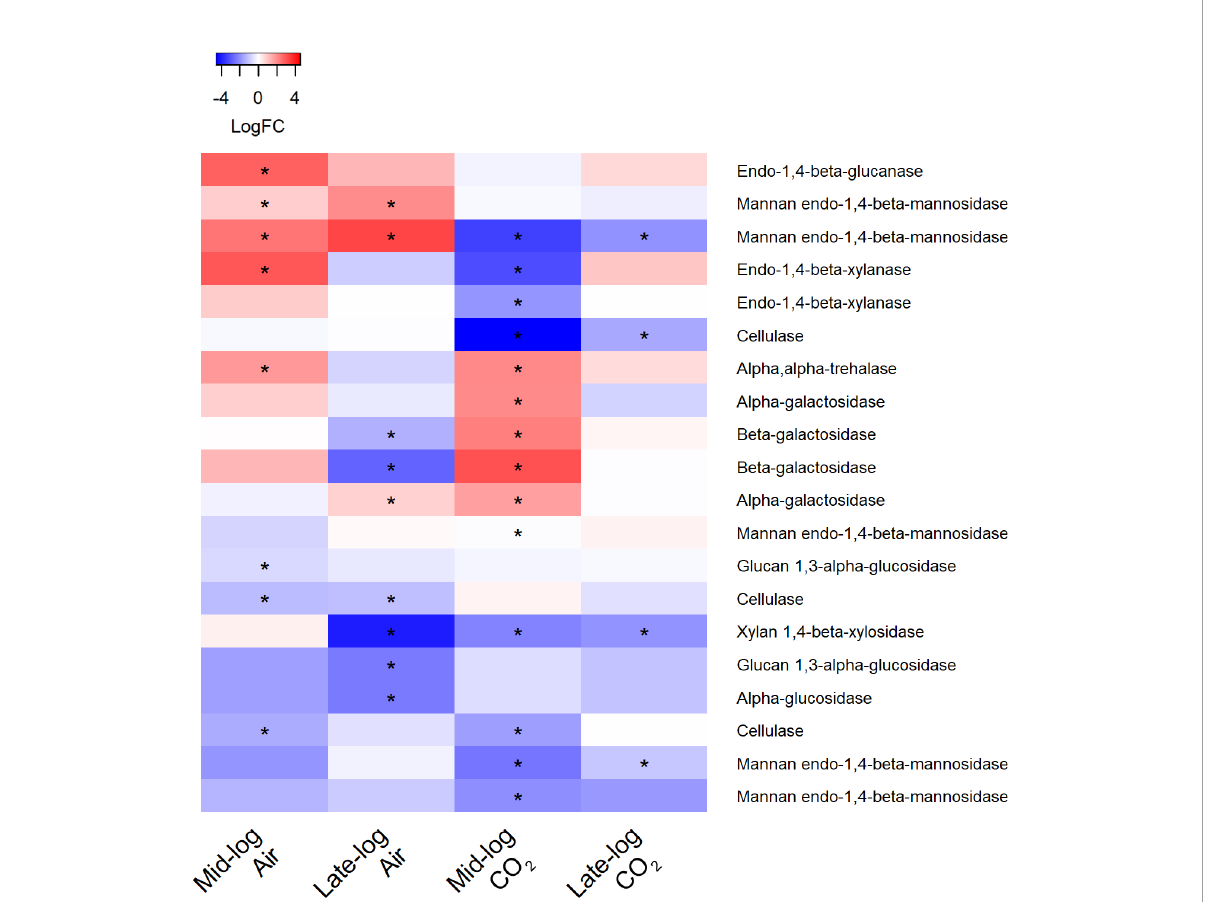
FIGURE 8 Heat map of differentially expressed transcripts encoding glycosyl hydrolases in S. obliquus grown in the presence of switchgrass in ambient (i.e., air) and 1% CO 2 during mid- and late-log phase growth. Differential expression is presented from a mean of triplicate samples as the log fold change of transcripts from cultures containing switchgrass compared to cultures of the algae alone. Stars indicate an adjusted p-value of less than